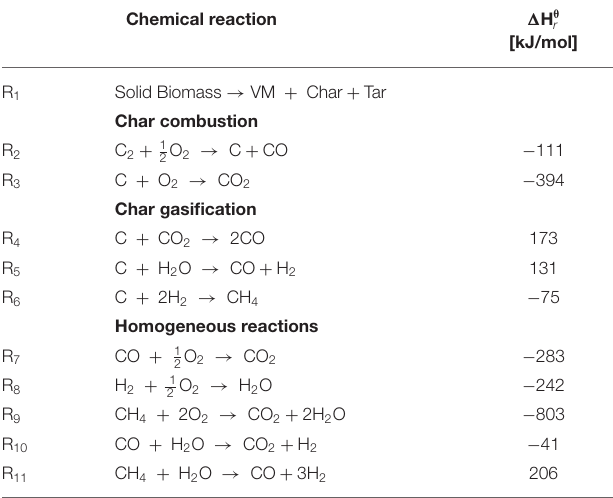
TABLE 1 | Chemical reactions in the gasification process. Chemical